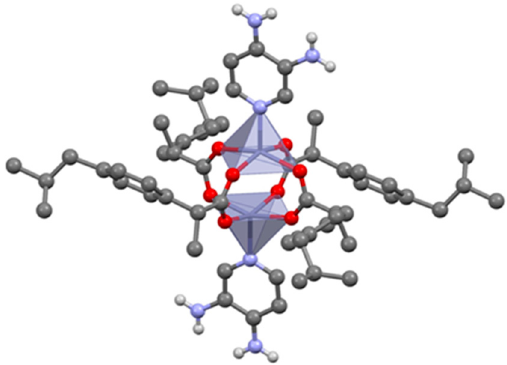
Figure 4. Monomer in Zn(IBU) 2 (AMI), H CH omitted for clarity.